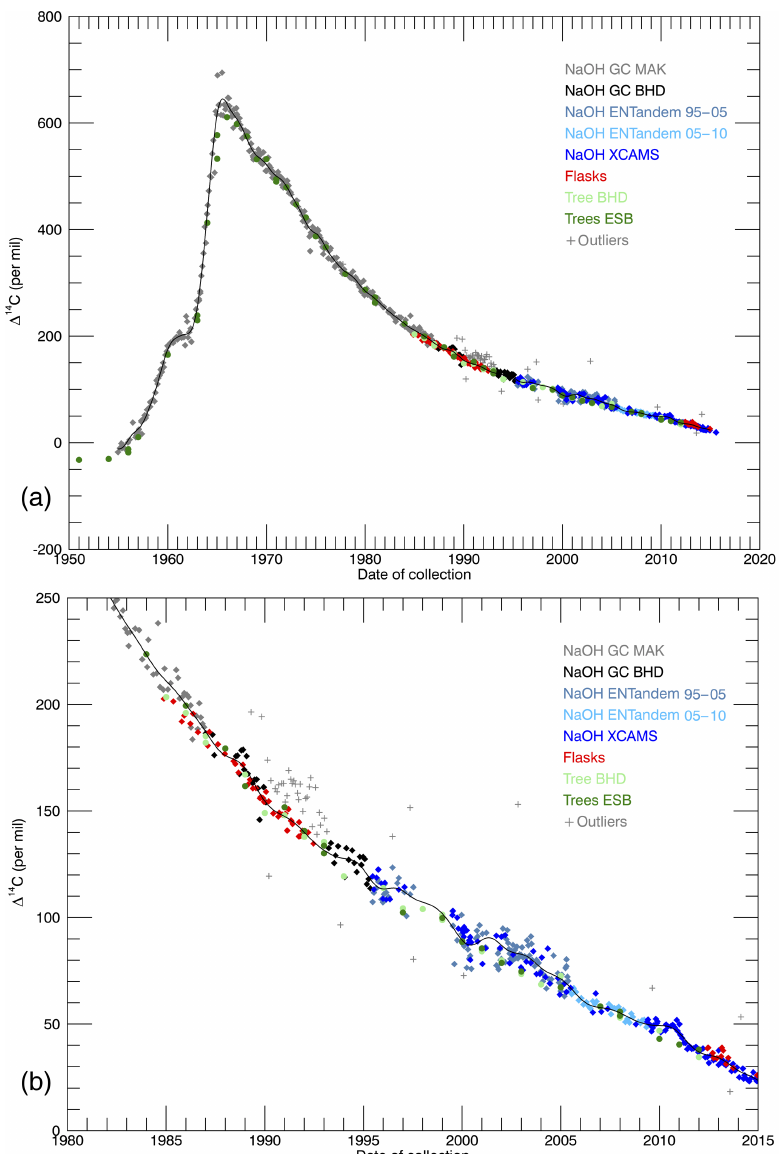
Figure 2. Wellington 14 CO 2 record showing all collection and measurement methods for the full record (a) and zoomed in for the period since 1980 (b) . Tree rings (green) and outliers (grey pluses) are excluded from the reported final dataset. The black line is the smooth curve fit to the final